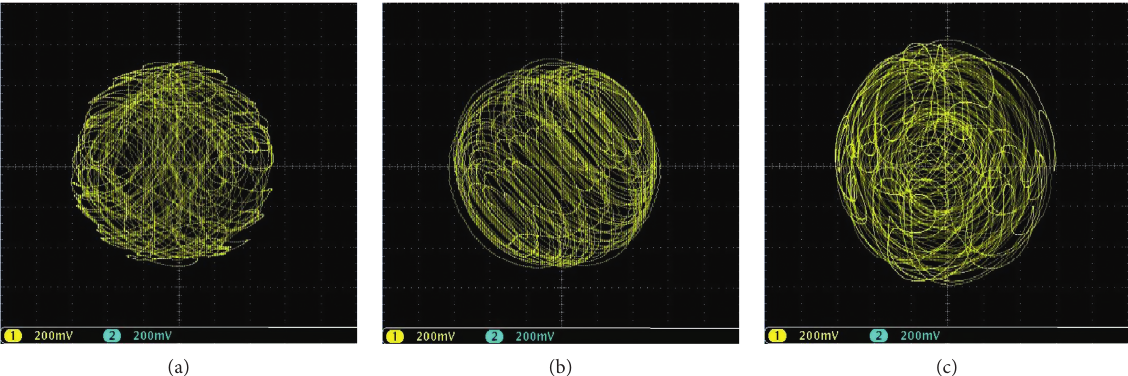
Figure 17: Phase portraits of Case 1 chaotic system using FPGA. (a) x-y plane. (b) x-z plane. (c) y-w plane.